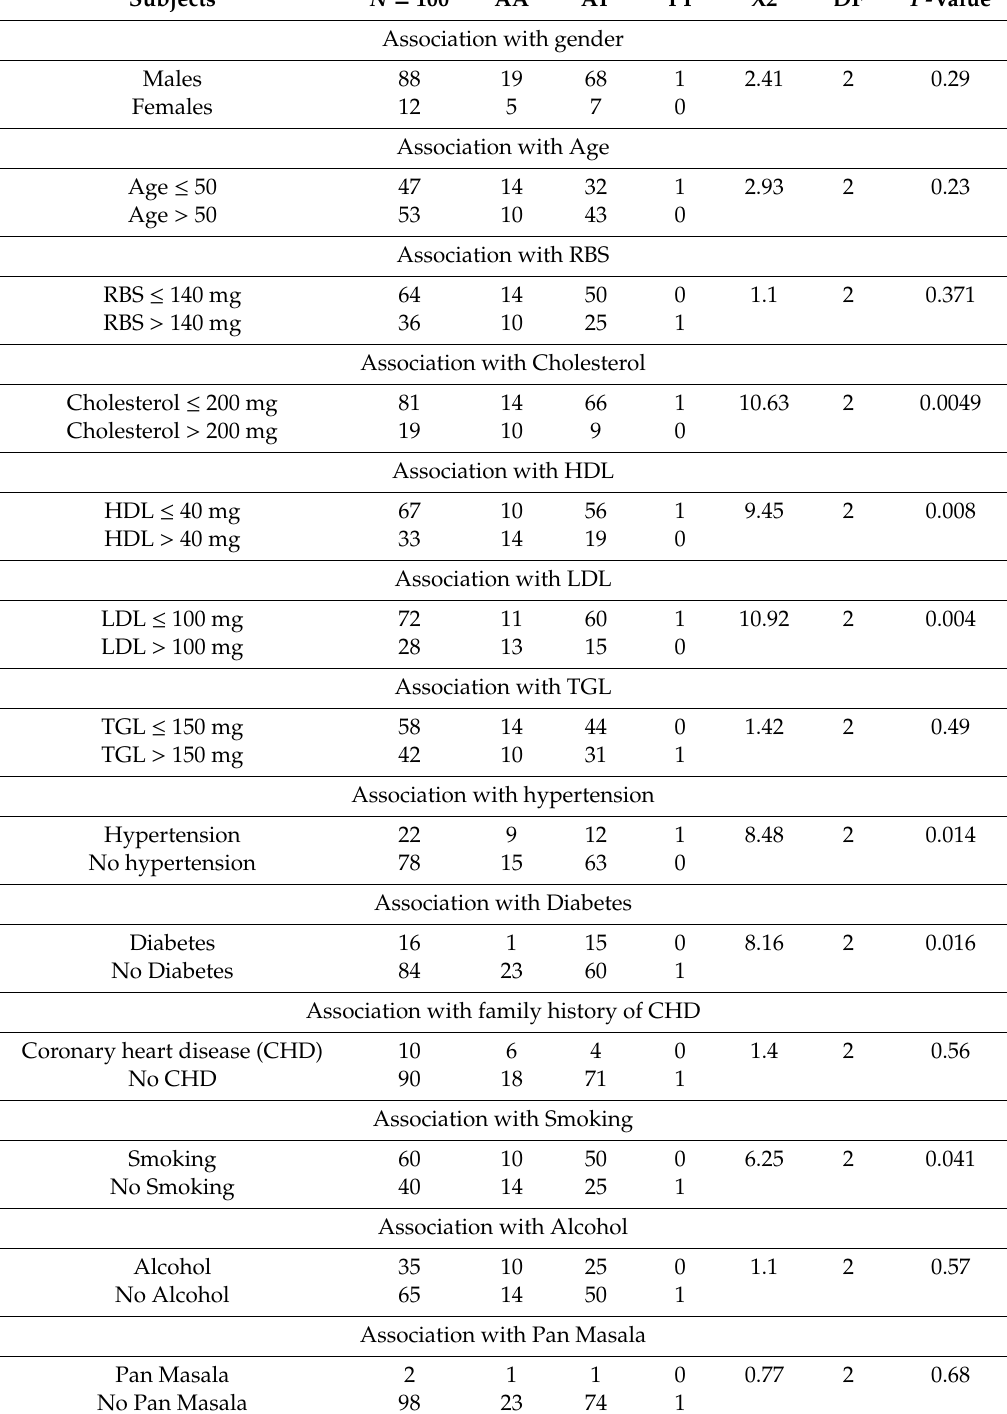
Table 4. Association of rs2274907 A > T genotype distribution with CAD clinical